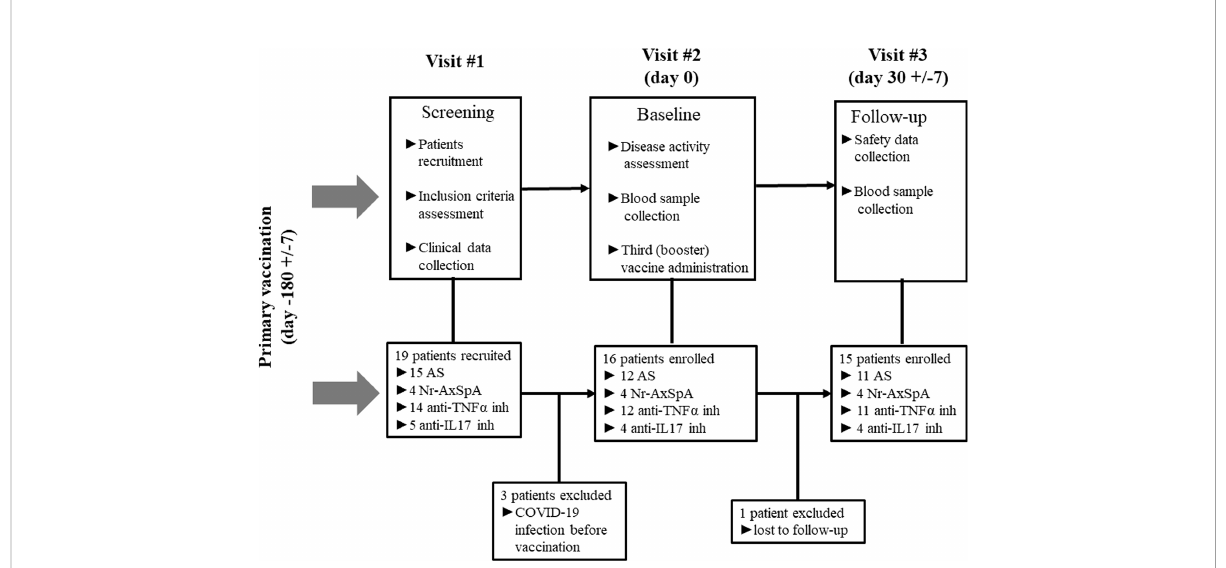
FIGURE 1 Study scheme (AS, ankylosing spondylitis; Nr-AxSpA, non-radiographic axial spondyloarthritis; TNF a , tumor necrosis factor alpha; IL, interleukin; COVID-19, coronavirus disease